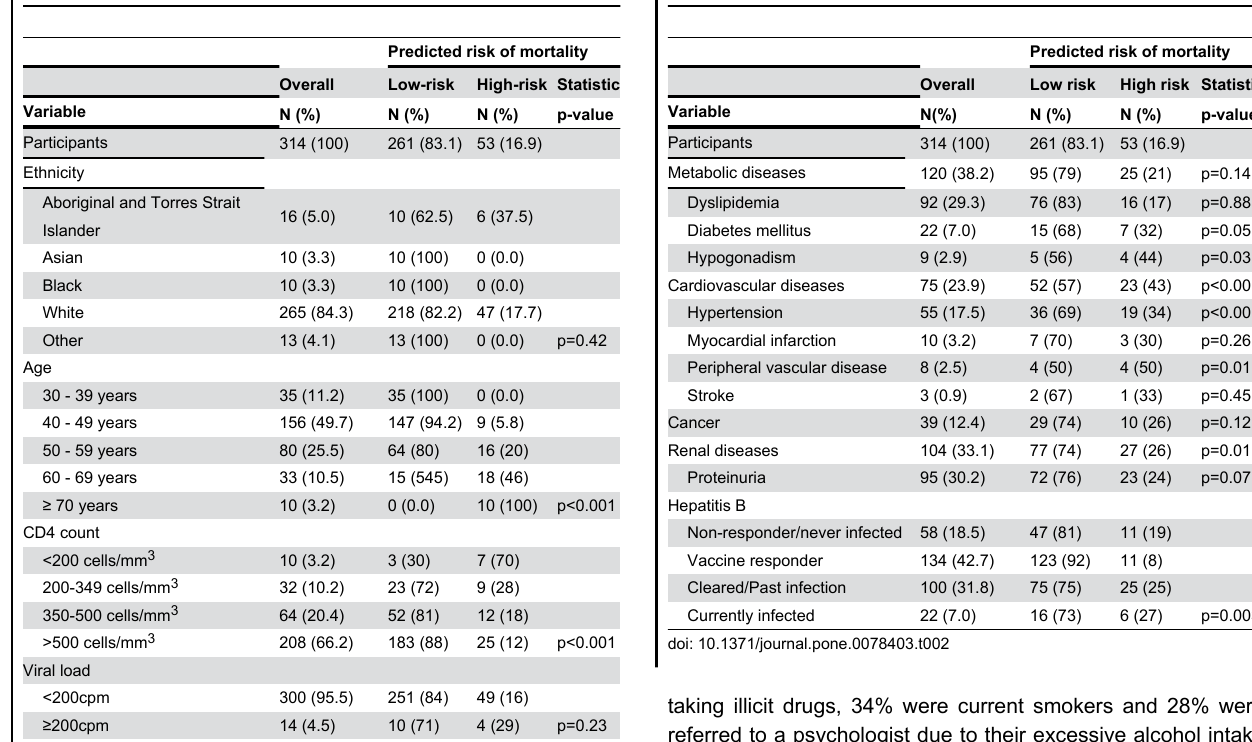
Table 1. Demographics, HIV surrogate markers and medical conditions included in VACS index as proportion of total cohort and of patients with predicted high and low mortality risk as estimated by VACS index.